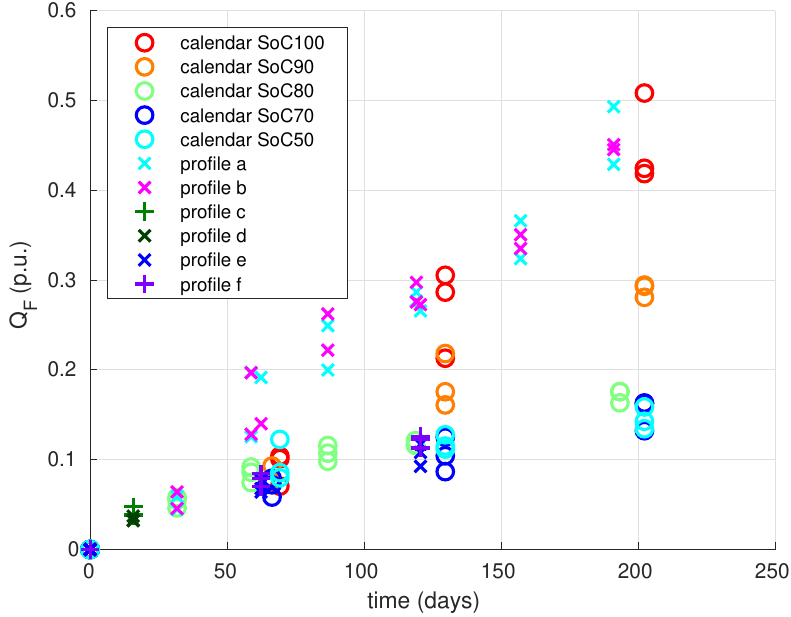
Figure 2. Capacity fade under different calendar/cycling ageing conditions. Relative values of capacity fade are expressed in p.u. which means “per